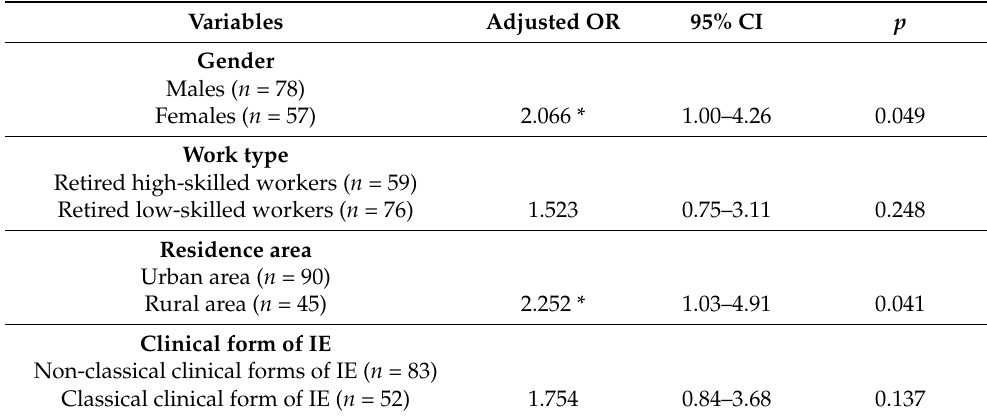
Table 3. The associations between gender, work type, residence area, clinical form of IE and perceived stress among patients with infective endocarditis ( n = 135): results of the logistic regression model.